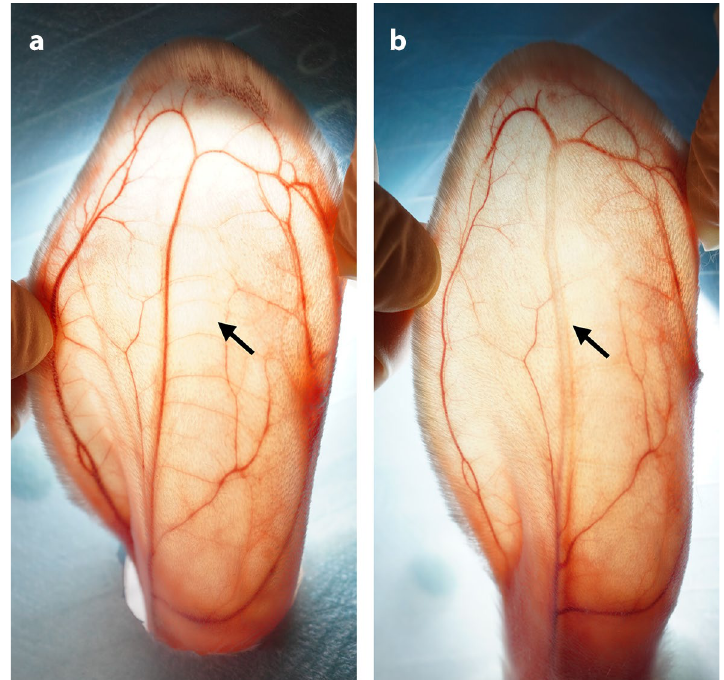
Figure 3. Immediate changes after intravascular filler injection. ( a ) before injection; ( b ) after injection. Arrow: the trunk of the central ear artery. Figure was created in Adobe Illustrator software (version 22.1; https:// www. adobe. com/ produ cts/ illus trator.